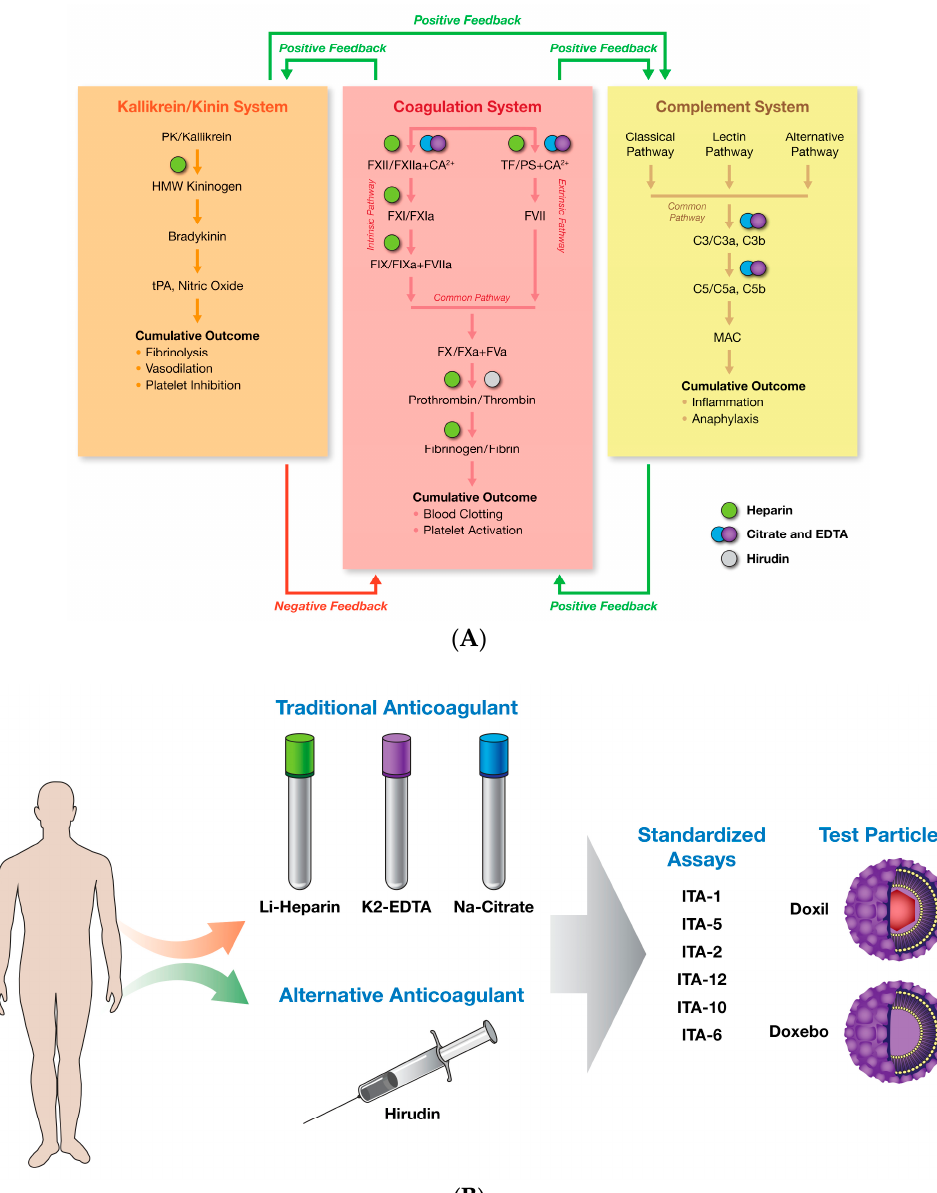
Figure 1. Rationale and study design. ( A ) Anticoagulants and their effects on various components of complement, plasma coagulation, and kinin/kallikrein systems are shown in this diagram. There is a cross-talk between these systems. Activation of the coagulation provides positive (i.e., agonist) feedback to the complement and kinin/kallikrein systems. Likewise, activated complement system stimulates coagulation, while activation of kinin/kallikrein system can also activate complement system. Cumulative outcome of the kallikrein/kinin system supplies a negative (i.e., inhibitory) feedback to the coagulation system to stop the blood clotting process and maintain hemostasis. Colored dots representing specific anticoagulant are shown above their respective protein targets. Unlike heparin, citrate, and EDTA, hirudin has a single target affecting only the coagulation cascade; ( B ) Schematic depiction of the study design. F—factor; C—complement; ITA—immunotoxicity assay